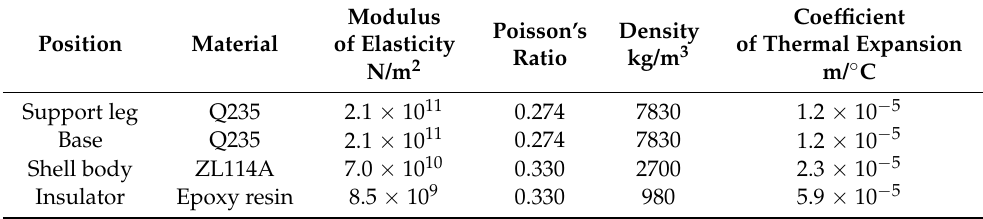
Table 2. Structural materials and properties of GIS equipment